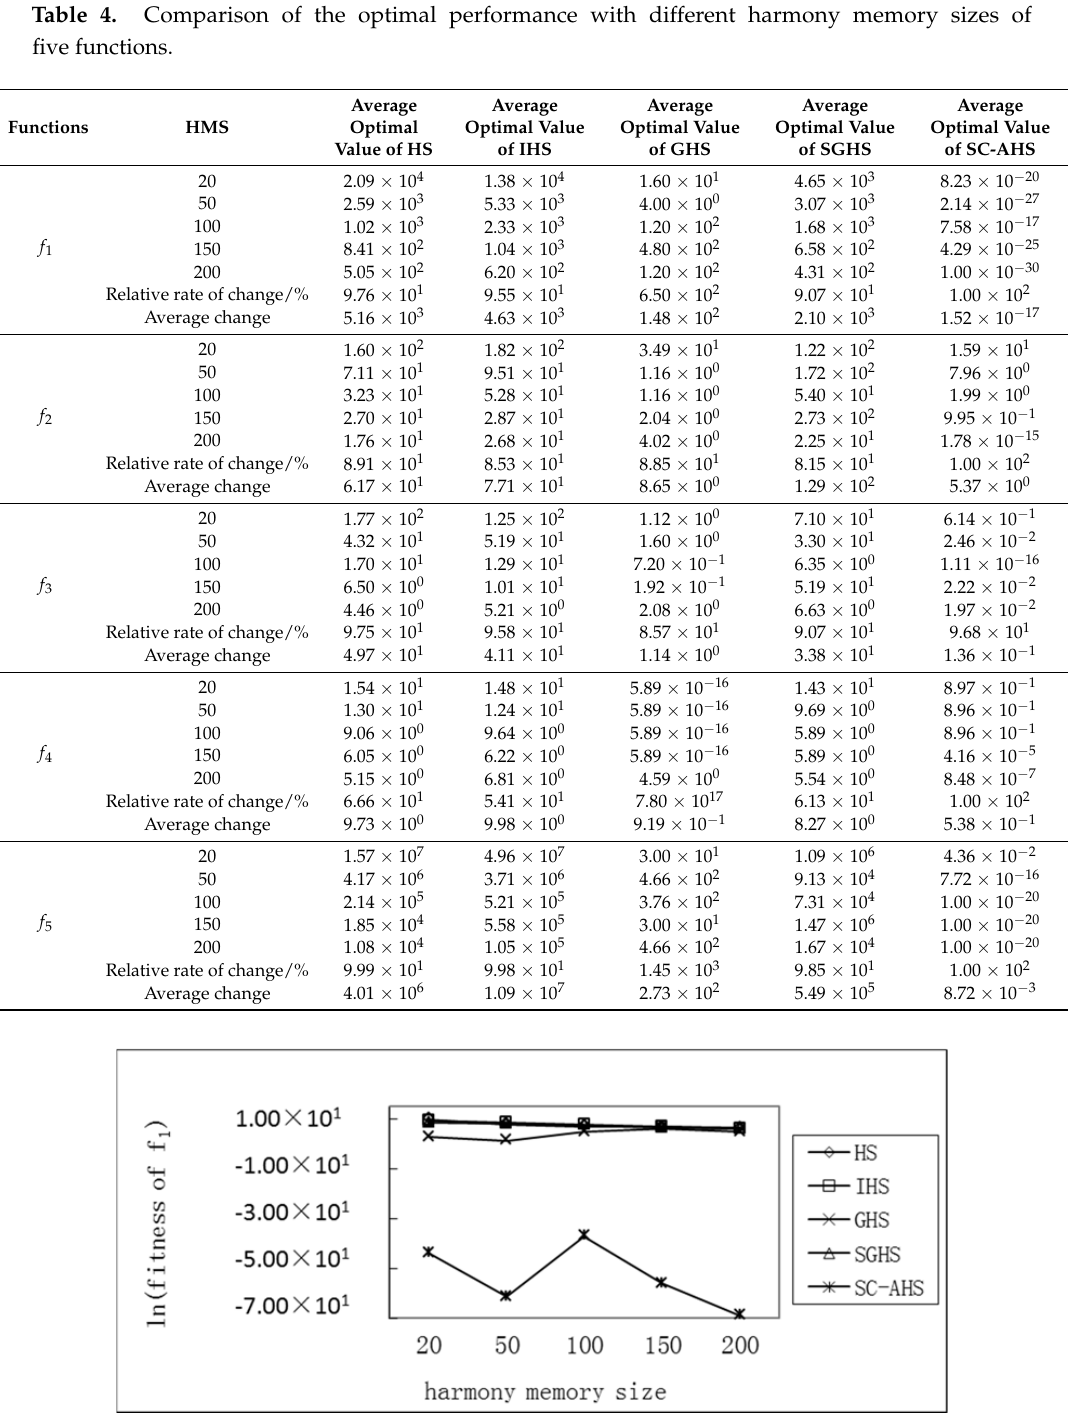
Figure 8. Comparison of the average optimum with different harmony memory sizes of the Rastrigrin function. Figure 9. Comparison of the average optimum with different harmony memory sizes of the Griewank function.